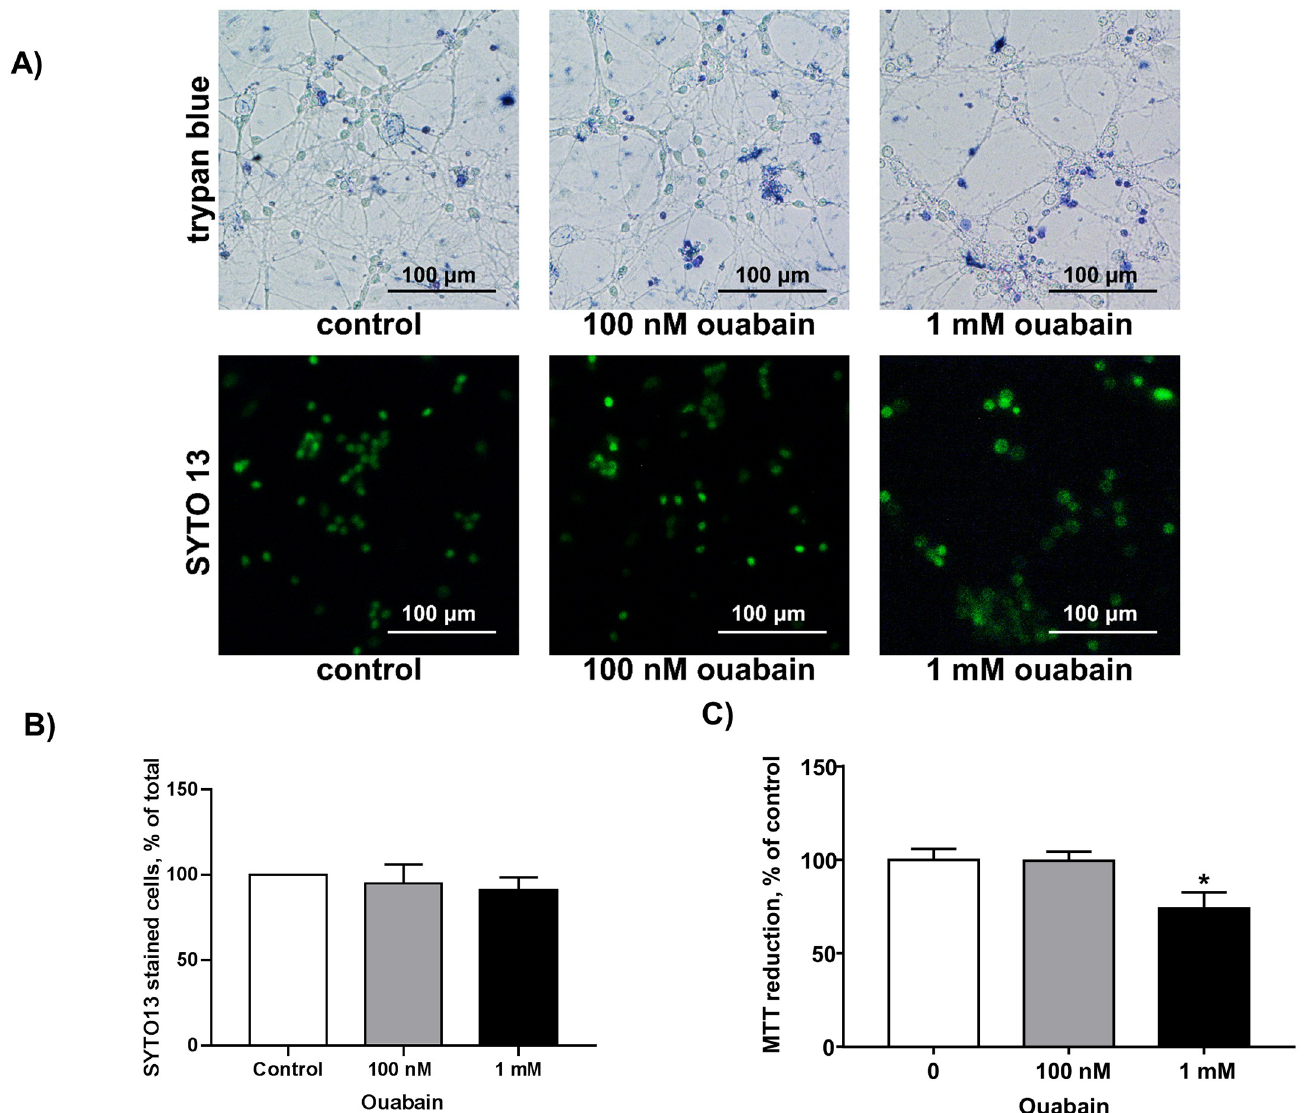
Fig 1. Estimation of viability of rat cerebellum granule cells by trypan blue staining and SYTO13 (A,B) and MTT reduction assay (C). A) Representative micrographs of control cells and cells exposed to 100 nM and 1 mM ouabain for 3 h. Bars = 100 μ m. B) Percentage of SYTO 13-stained control cells and cells exposed to 100 nM and 1 mM ouabain for 3 h. C) MTT reduction assay of control cells and cells exposed to 100 nM and 1 mM ouabain for 3 h. Means ± SD for 4 ( B ) and 8 ( C ) independent experiments are shown. � —p < 0.05.